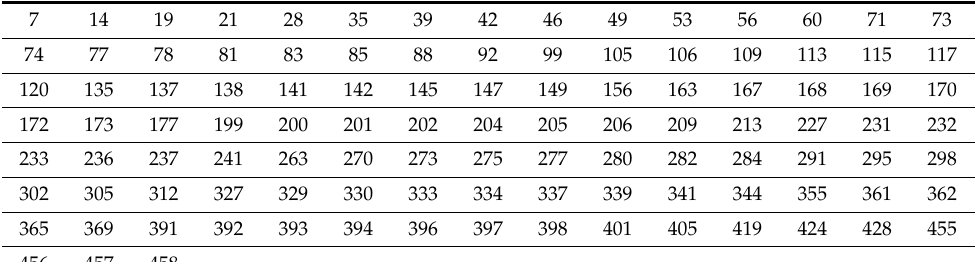
Table 2. x1 corresponding to block P texture template (decimal).